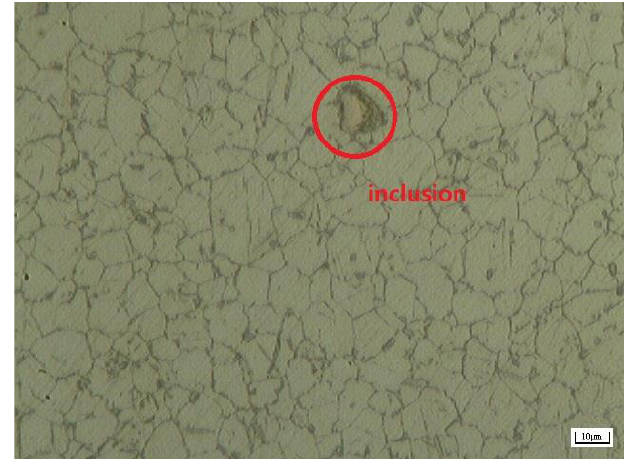
Figure 1. Microstructural result of GH4169.